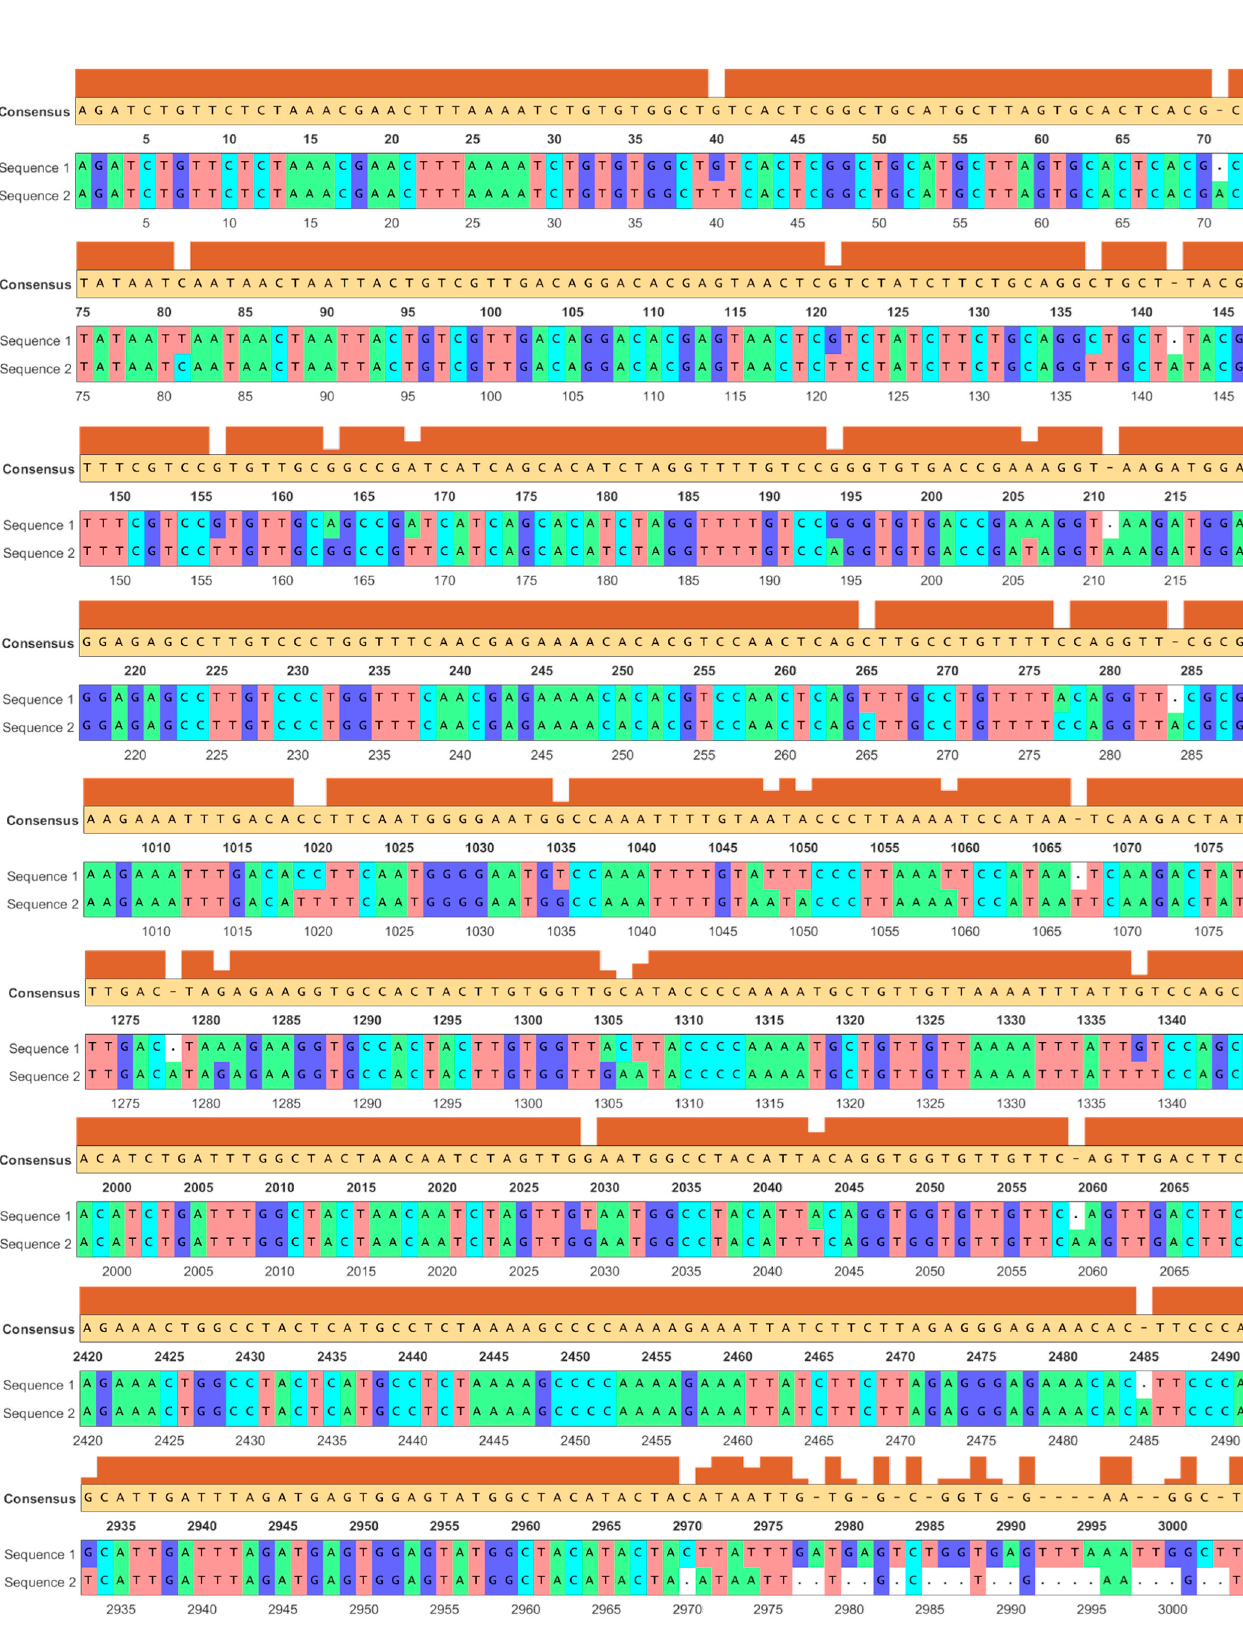
Figure 7. Snapshots of different positions from sequence alignment between the original COVID-19 and generated nucleotide sequence. Sequence 1 is the original COVID-19 sequence, and sequence 2 is the generated COVID-19 variant using the proposed technique. Consensus sequence is defined in Section 3.3.